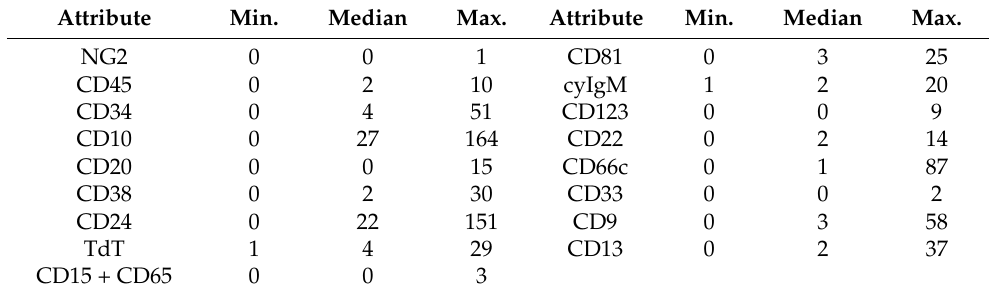
Table 1. Descriptive statistics of antigen expression.